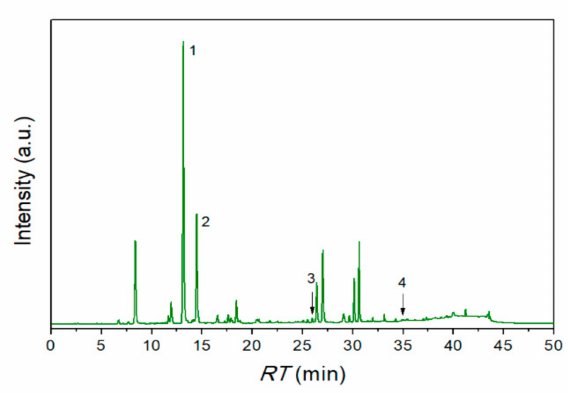
Figure 1. Chromatogram of SE extract at 326 nm: 1 –Chlorogenic acid: RT = 13.160 ± 0.002 min; c = 14.389 ± 0.018 mg / g extract; 2 –Ca ff eic acid: RT = 14.500 ± 0.004 min; c = 2.997 ± 0.004 mg / g extract; 3 –Rutin: RT = 25.970 ± 0.002; c = 0.564 ± 0.001 mg / g extract; 4 –Quercetin: RT = 34.952 ± 0.002, c = 0.073 ± 0.001 mg / g